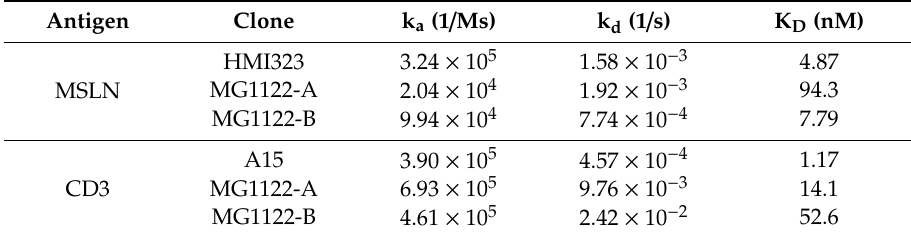
Table 1. A ffi nity of monoclonal and bispecific antibodies to human MSLN and CD3.